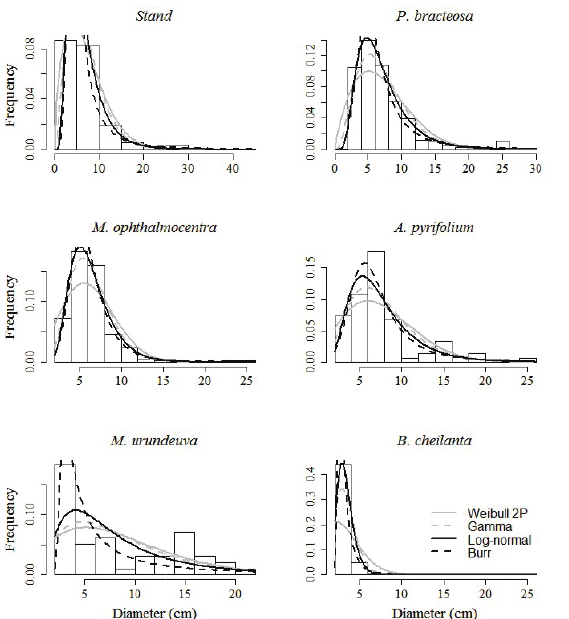
figure 4 – Cumulative diameter distribution and validation of the fitted functions for the stand and HIV